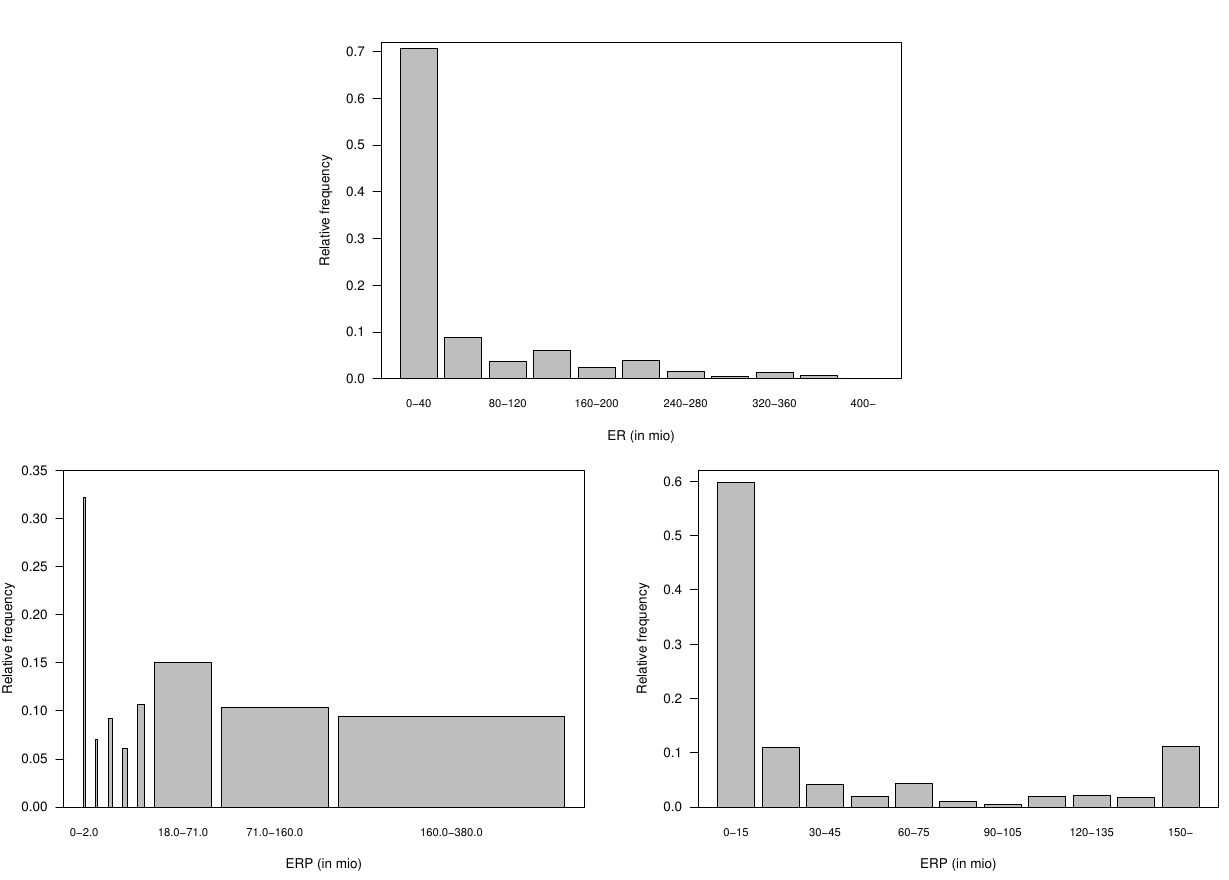
Figure A6. Relative frequency of the equalization reserves ( ER ) and of the one of the prior year ( ERP ) for non-life undertakings. The figure presents twice the relative frequency of ERP : once sliced by the optimal bin out of our model and once sliced by equal bands, whereby the last band includes all remaining higher